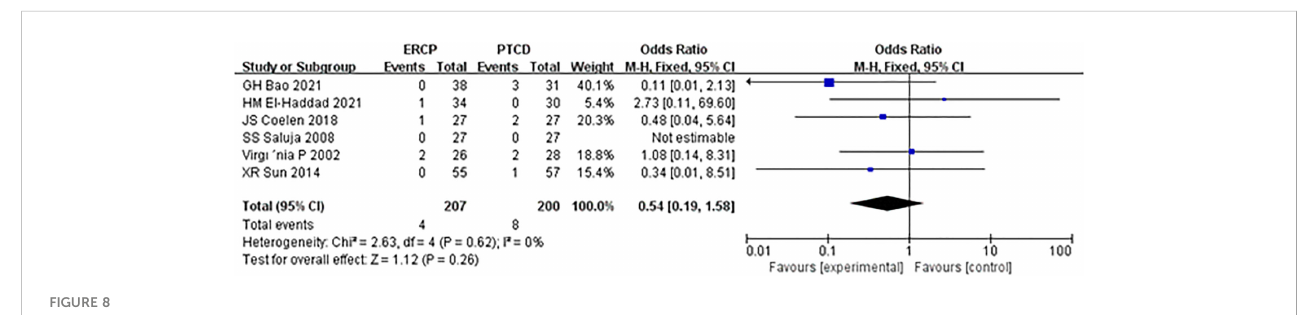
FIGURE 8 Forest plot comparing the incidence of procedure-related hemorrhage.